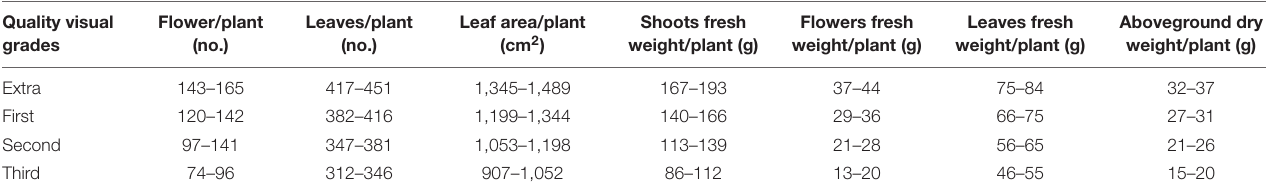
TABLE 2 | Parameters and ranges of the four quality visual grades for petunia plants according to https://www.flowerscanadagrowers.com/uploads/2016/11/grades %20&%20standards%20for%20foliage%20plants1.pdf. Quality visual Flower/plant grades